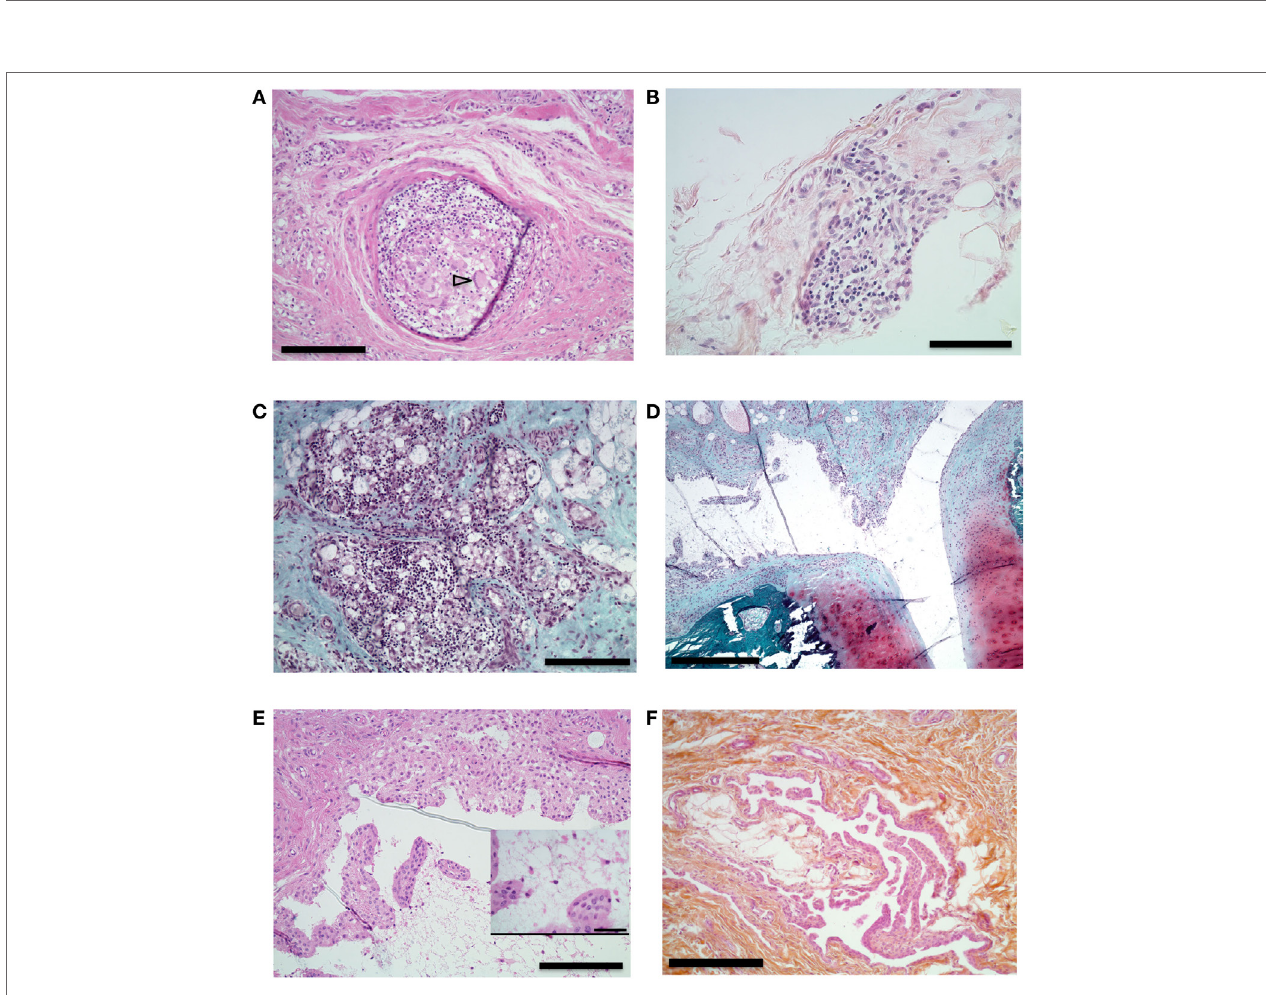
FigUre 6 | Histological analysis of synovial proliferation. Sections with hematoxylin eosin (a,B,e,F) or safranin O and Fast Green (c,D) stain. (a) Synovial membrane of knee of an animal that received intra-articular (IA) injection containing incomplete Freund’s adjuvant (IFA). Arrowhead shows multinucleated gigantic cell. 10 × magnification, bar 200 µm. (B) Synovial membrane of right knee of an animal that received IA boost with citrullinated peptides + IFA and presented prolonged swelling. 20 × magnification, bar 100 µm. (c) Knee synovial membrane. 10 × magnification, bar 200 µm. (D) Knee synovial membrane, bone, and cartilage of the same animal. 4 × magnification, bar 500 µm. (e) Right knee synovial membrane of an animal that received an IA boost with citrullinated peptides + IFA and presented prolonged swelling. Insert shows fibrin and leukocyte in the synovial cleft. 10 × magnification, bar: 200 µm, insert bar 50 µm. (F) Section of metacarpophalangeal joint synovial membrane of an animal without clinically identified manifestation on these joints. 10 × magnification bar 200 µm.